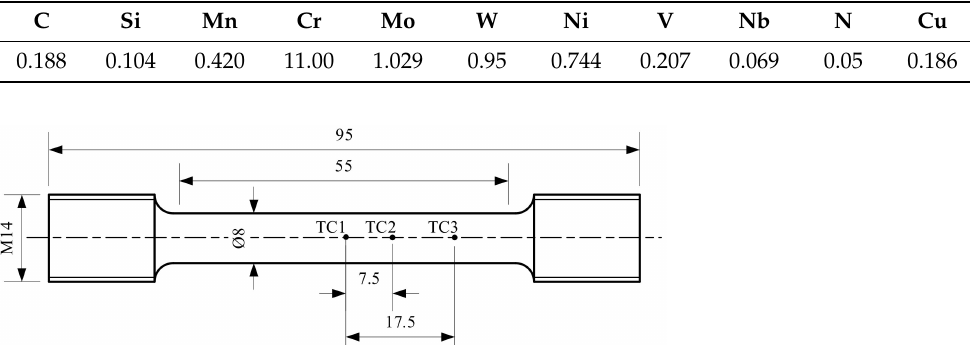
Table 1. Chemical composition of X12 alloy steel (mass percentage: wt.%) [26].